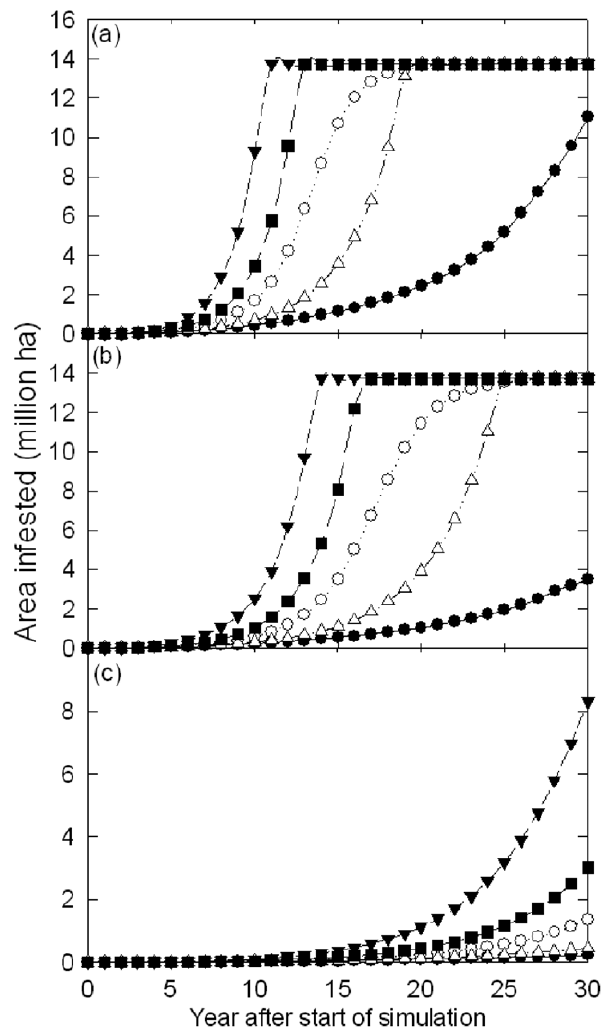
Figure 7. Change in area infested by Thaumetopoeapityocampa from the simulation start under the (a) no control (b) little control and (c) good control spread scenarios. On all figures the lines represent trajectories from spread simulations showing the minimum, (filled circles), maximum (filled triangles), 5 th (open triangles), 50 th (open circles), and 95 th (closed squares) percentiles. Note the variation in scale between figure panels.